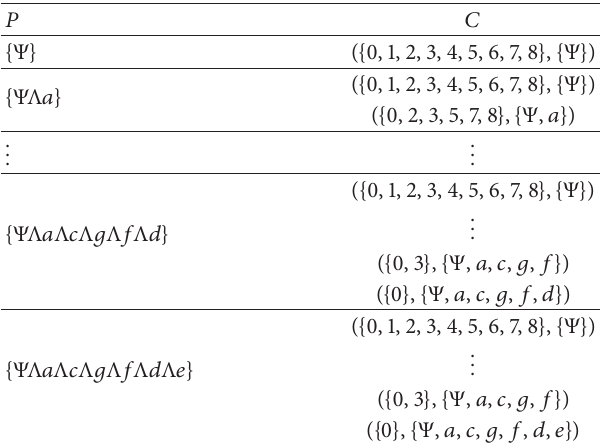
Table 3: The update on set 𝐶 , along with the update on the path shown in Figure